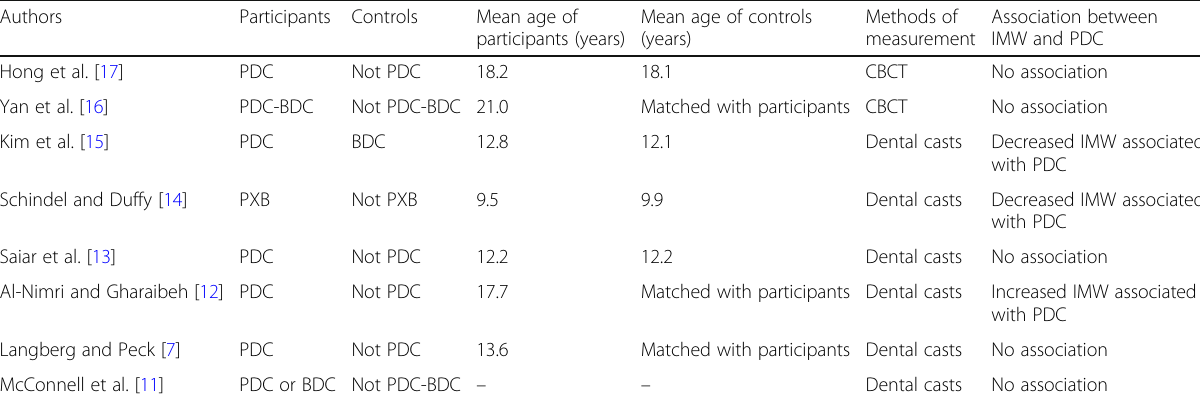
Table 1 Literature review about the relationship between displaced/impacted maxillary canines and the intermolar